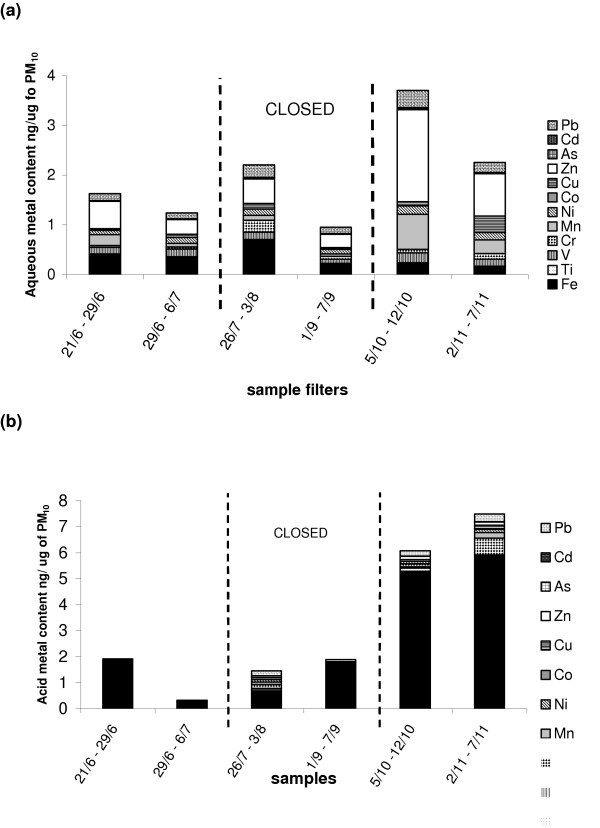
Metal content of PM10 collected before, during and after the closure of the Redcar Corus steel plant. (a) Aqueous extractable (b) acid extractable metal content of PM10. Measurements were conducted by ICP-MS and values are of individual filter samples